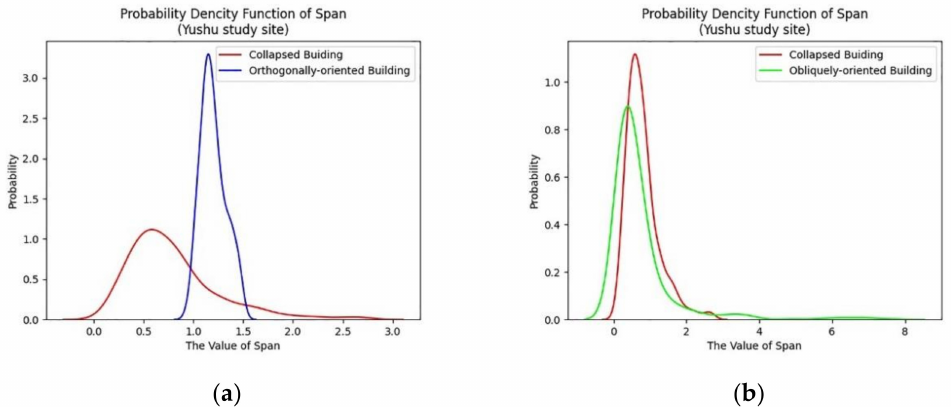
Figure 17. The pdfs of the total power (Span) feature: ( a ) pdfs of collapsed buildings and orthogonally-oriented buildings; ( b ) pdfs of collapsed buildings and obliquely-oriented buildings.